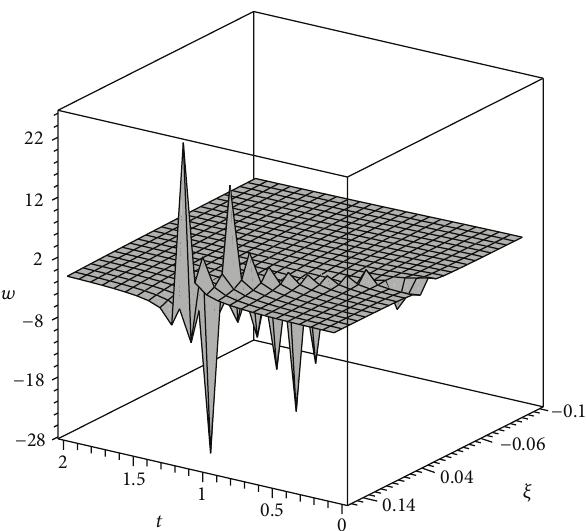
Figure3:Dynamicalequationofstate 𝜔(𝑡) variesfordifferentvalues of the 𝑡 and nonminimal coupling parameter 𝜉 by (11) and specific choosing for parameters